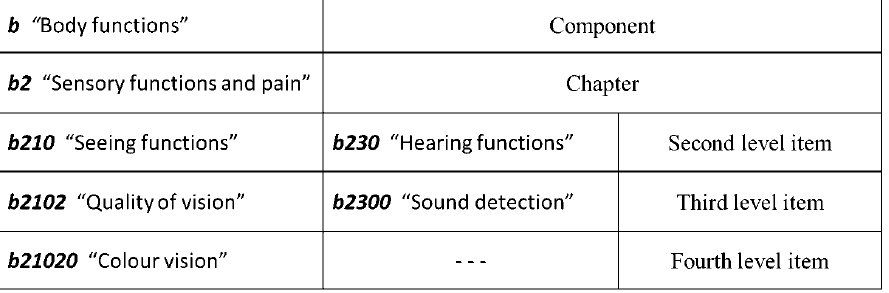
Figure 3. An example of ICF illustrating the structure of the classification.